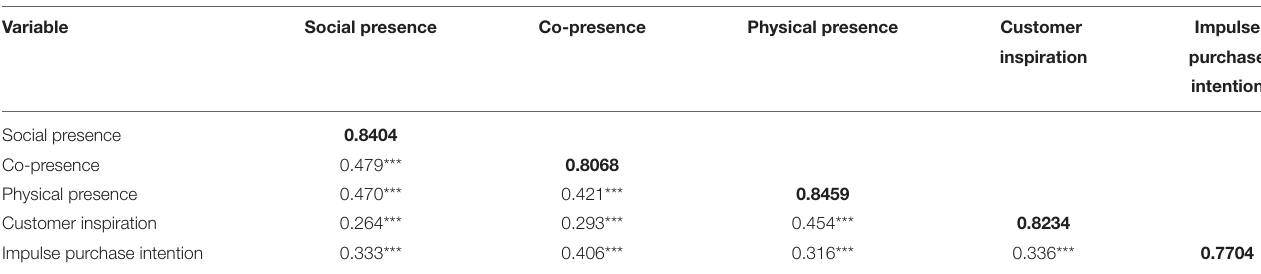
TABLE 6 | Discriminant validity test between